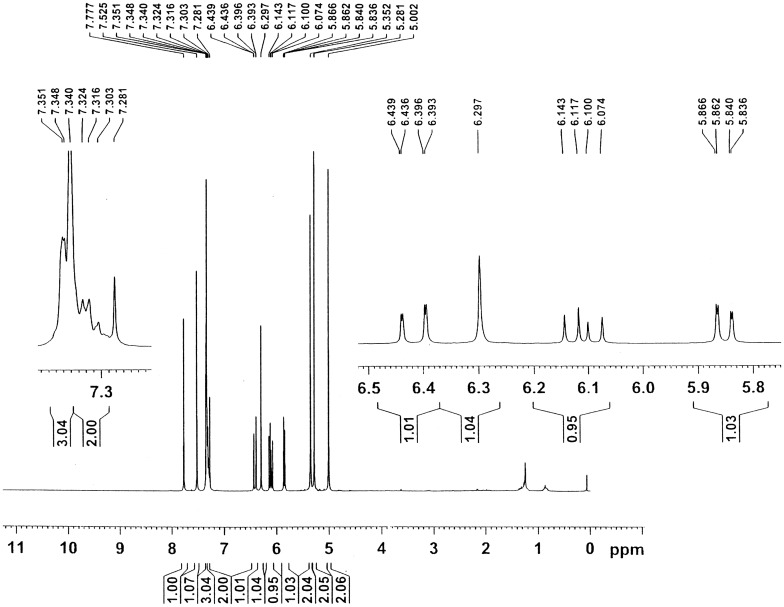

1H NMR spectrum of the monomer 6 in CDCl3
.